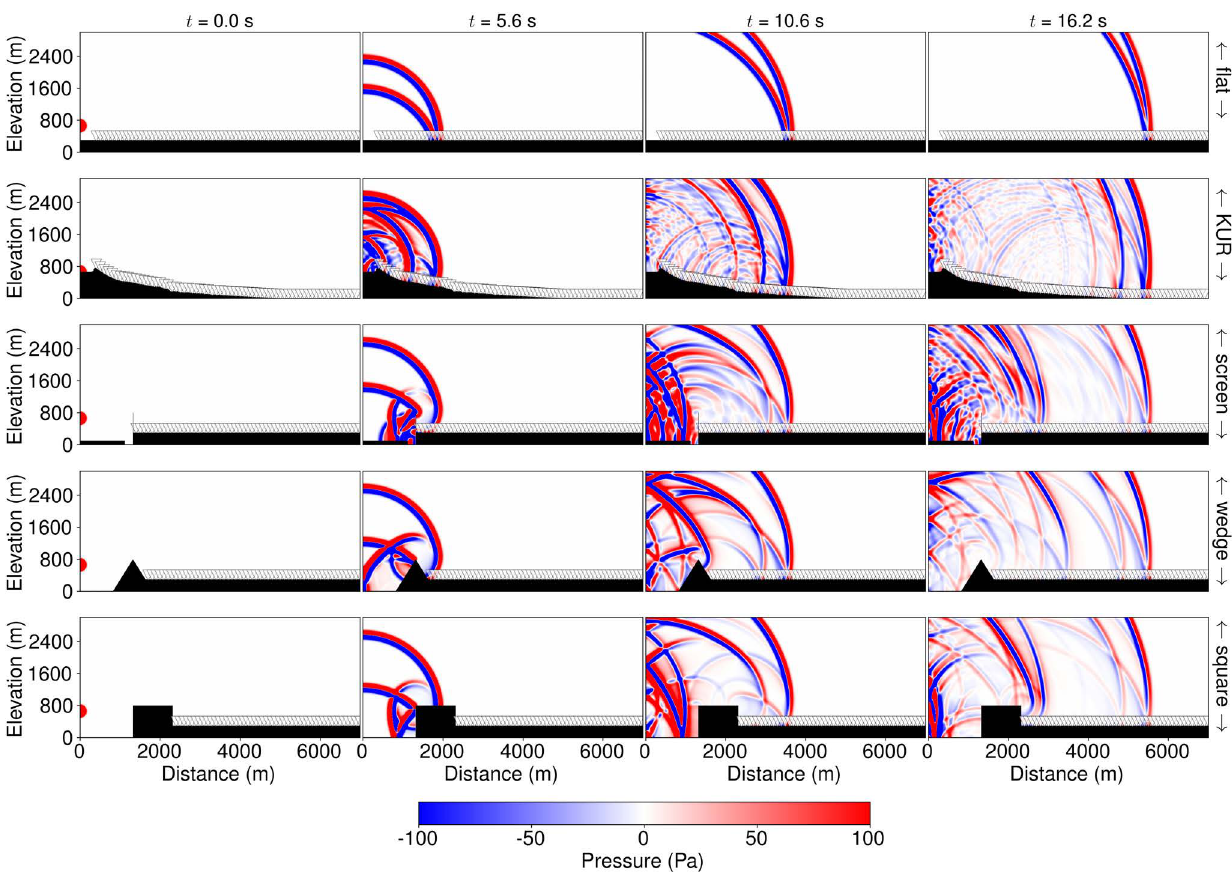
Figure 2: Wavefield snapshots for infrasound propagation simulations over five lower boundary types. Each row represents a time sequence from left to right for one lower boundary. From top to bottom these lower boundaries are flat ground, Sakurajima topography (KUR profile), thin screen, wedge, and wide barrier, respectively. Downward triangles represent synthetic receivers. The full model space dimensions are 12 ˆ 12 km and simulation run times are 34